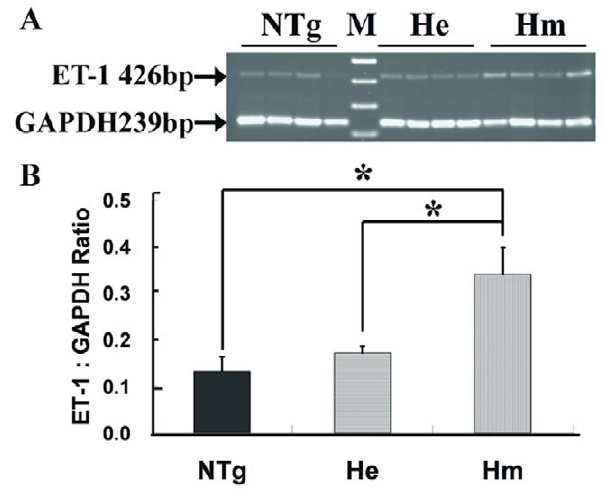
Figure 1. Semi-quantitative rt-PCR analysis showing total ET-1 mRNA expression in the retinae of non-transgenic (NTg), heterozygous (He) and homozygous (Hm) TET-1 mice. A: Ethidium bromide-stained agarose gels of rt-PCR products of ET-1, showing increased ET-1 mRNA expression in transgenic mouse retina. The molecular size marker (M) was 1 kb plus marker. B: Histograms showing the levels of ET-1 mRNA expression normalized to that of GAPDH. n=4 for each experimental group. *: p , 0.05 (Kruskal-Wallis Test).